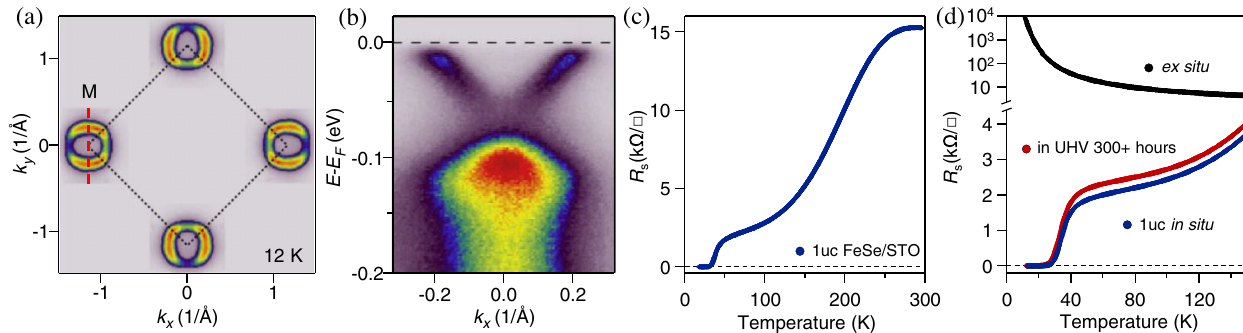
FIG. 1. Combined ARPES and in situ electrical resistivity measurement of single-layer FeSe = SrTiO 3 . Measurements in (a) – (c) are conducted on the same sample. (a) Fermi surface intensity map for an as-grown 1 uc FeSe = SrTiO 3 sample held at 12 K, integrated over (cid:2) 5 meV of E F . The black dashed line indicates the boundary of the 2-Fe Brillouin zone. The electron pockets comprise 5.5% of the Brillouin zone area. (b) Photoemission intensity at M [dashed red line in (a)] taken at 12 K. (c) Temperature-dependent sheet resistance for 1 uc FeSe = SrTiO 3 . (d) Stability of the superconducting state for a separate sample after growth (blue line), long-term UHV storage (red line), and after momentary exposure to an inert gas atmosphere (black